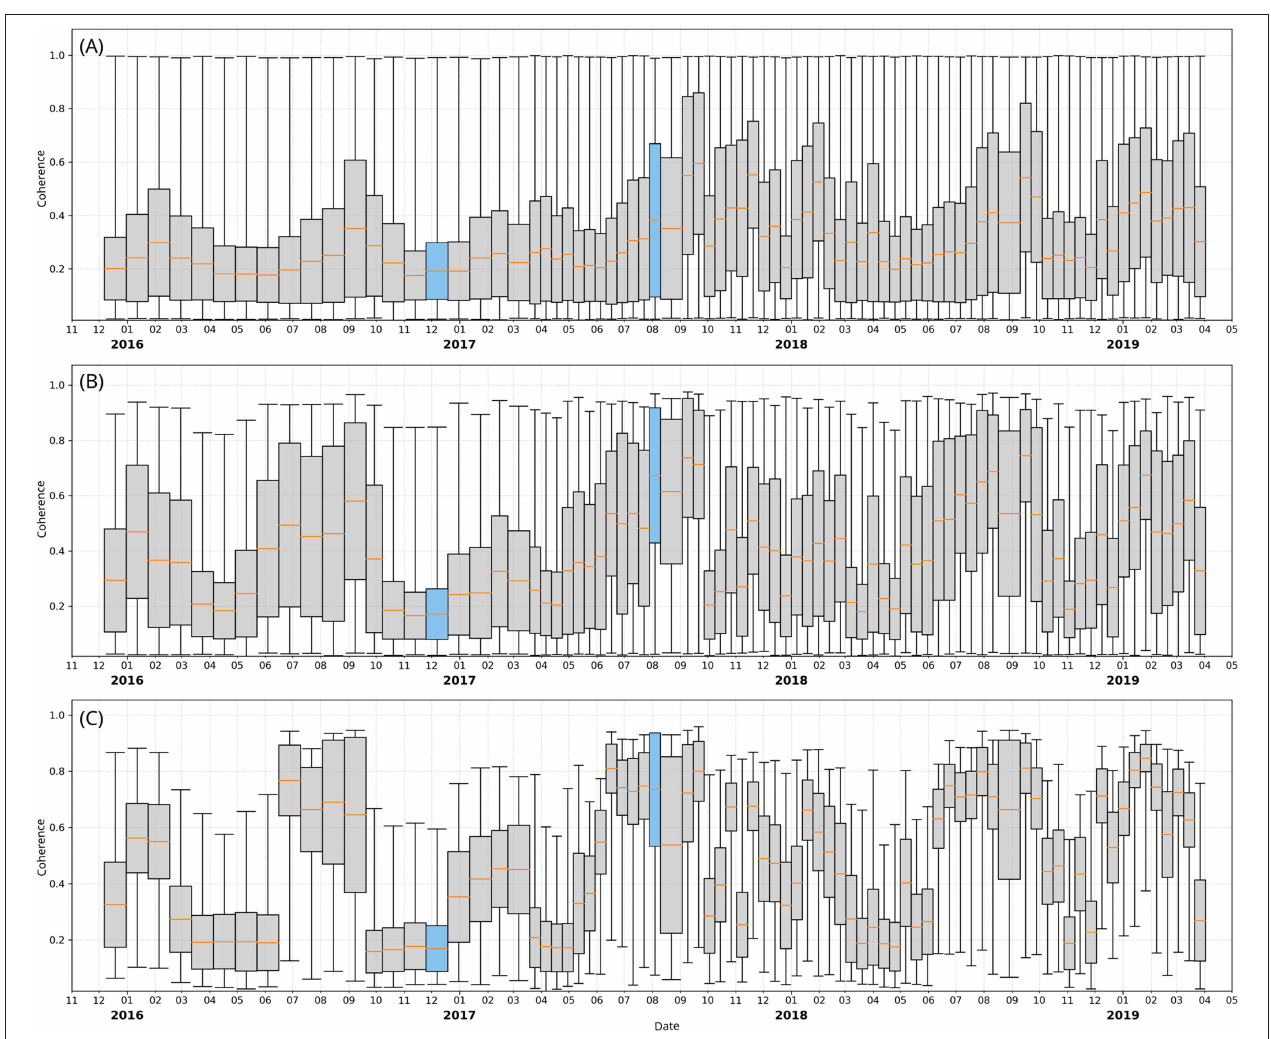
FIGURE 5 | Box plots of OSARIS coherence processing results for the full time series and (A) the wider study area, (B) the core study area in the Ala Archa mountain range, and (C) a rock glacier as example for an individual landform (cf. Figures 2 , 4 ). Box width shows the timespan covered by individual scene pairs. Blue colors mark the time steps (2016-11-25 to 2016-12-19 and 2017-07-29 to 2017-08-10) that are investigated in more detail in the subsequent figures. The figure was generated using OSARIS’ “pyStatisticPlot” based on output of the “Statistics” module. Contains modified Copernicus Sentinel data 2015–2019.